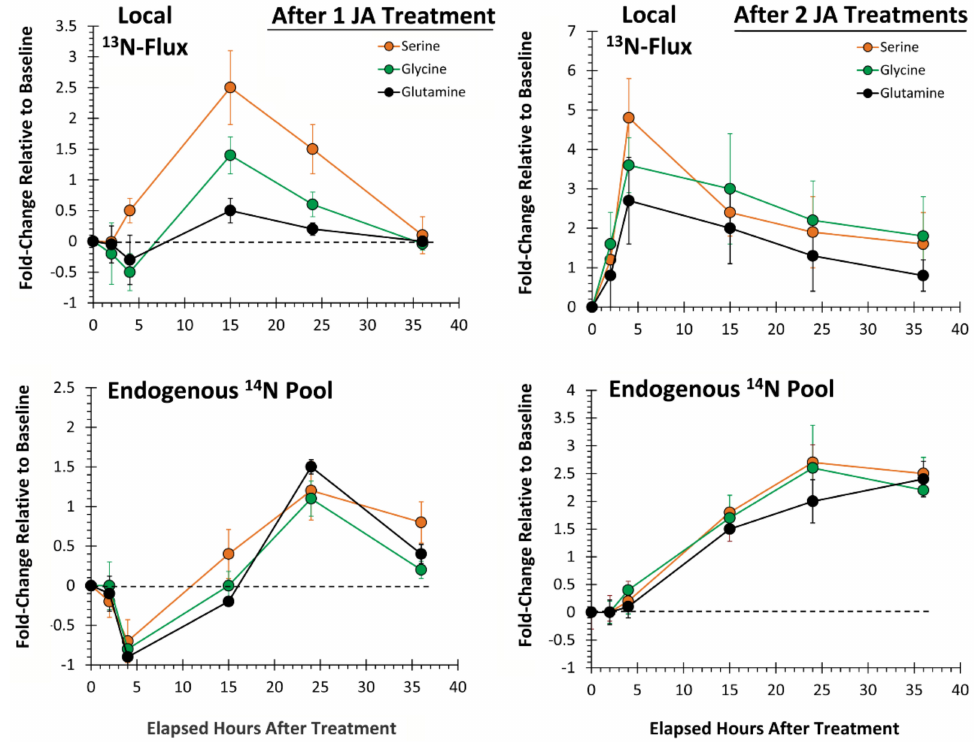
Figure 6. Local tissue responses to 500 µ M JA treatments—partitioning of ‘new’ nitrogen (as 13 N) into serine, glycine and glutamine is presented after sequential JA treatments (top panels). Change in